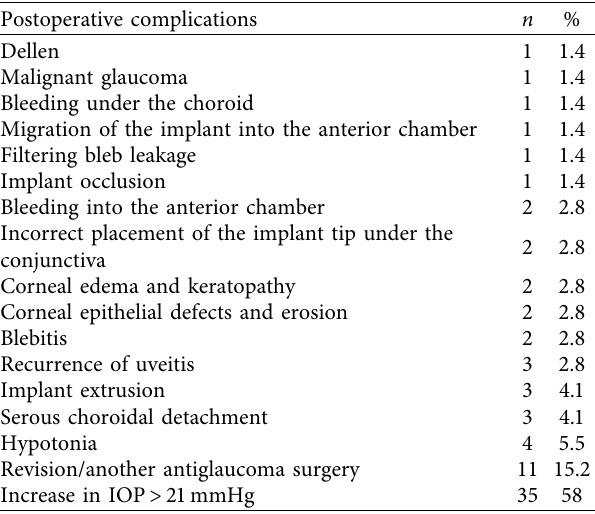
Table 4: Postoperative